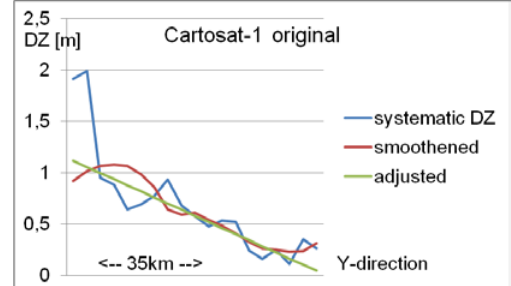
Fig. 18. Systematic height errors in Y-direction, Warsaw, filtered Cartosat-1 DSM against reference